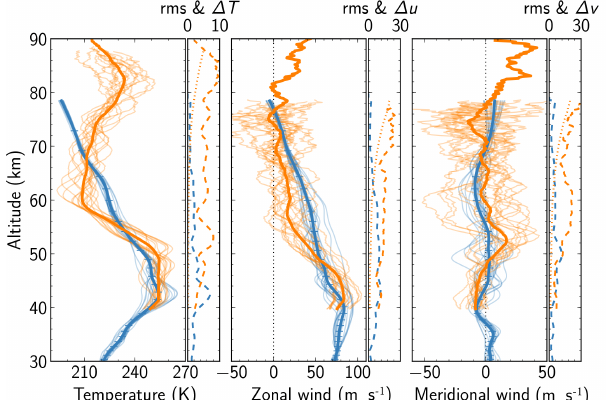
Figure 5. Temperature and horizontal winds for the night of 20/21 January 2015; lidar (orange); ECMWF (blue). Thin lines de- note 1h profiles; thick lines denote the nightly mean profiles, the horizontal bars mark the model levels of ECMWF data for one sam- ple profile; dashed and dotted lines show the rms and the mean mea- surement uncertainty of the 1h profiles,